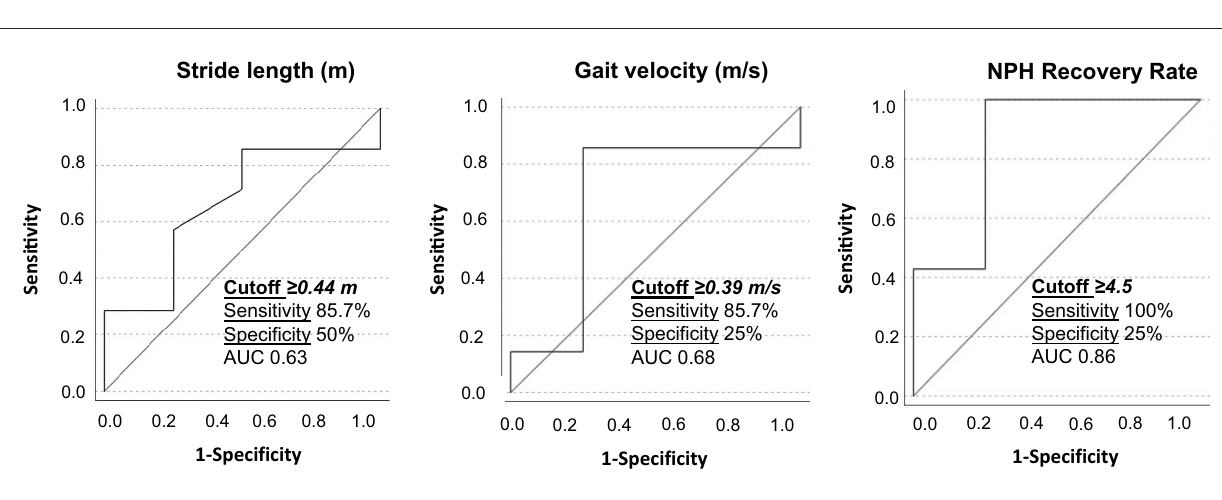
after VP-shunt placement, patients experience an improvement in gait performance. A statistically significant difference in